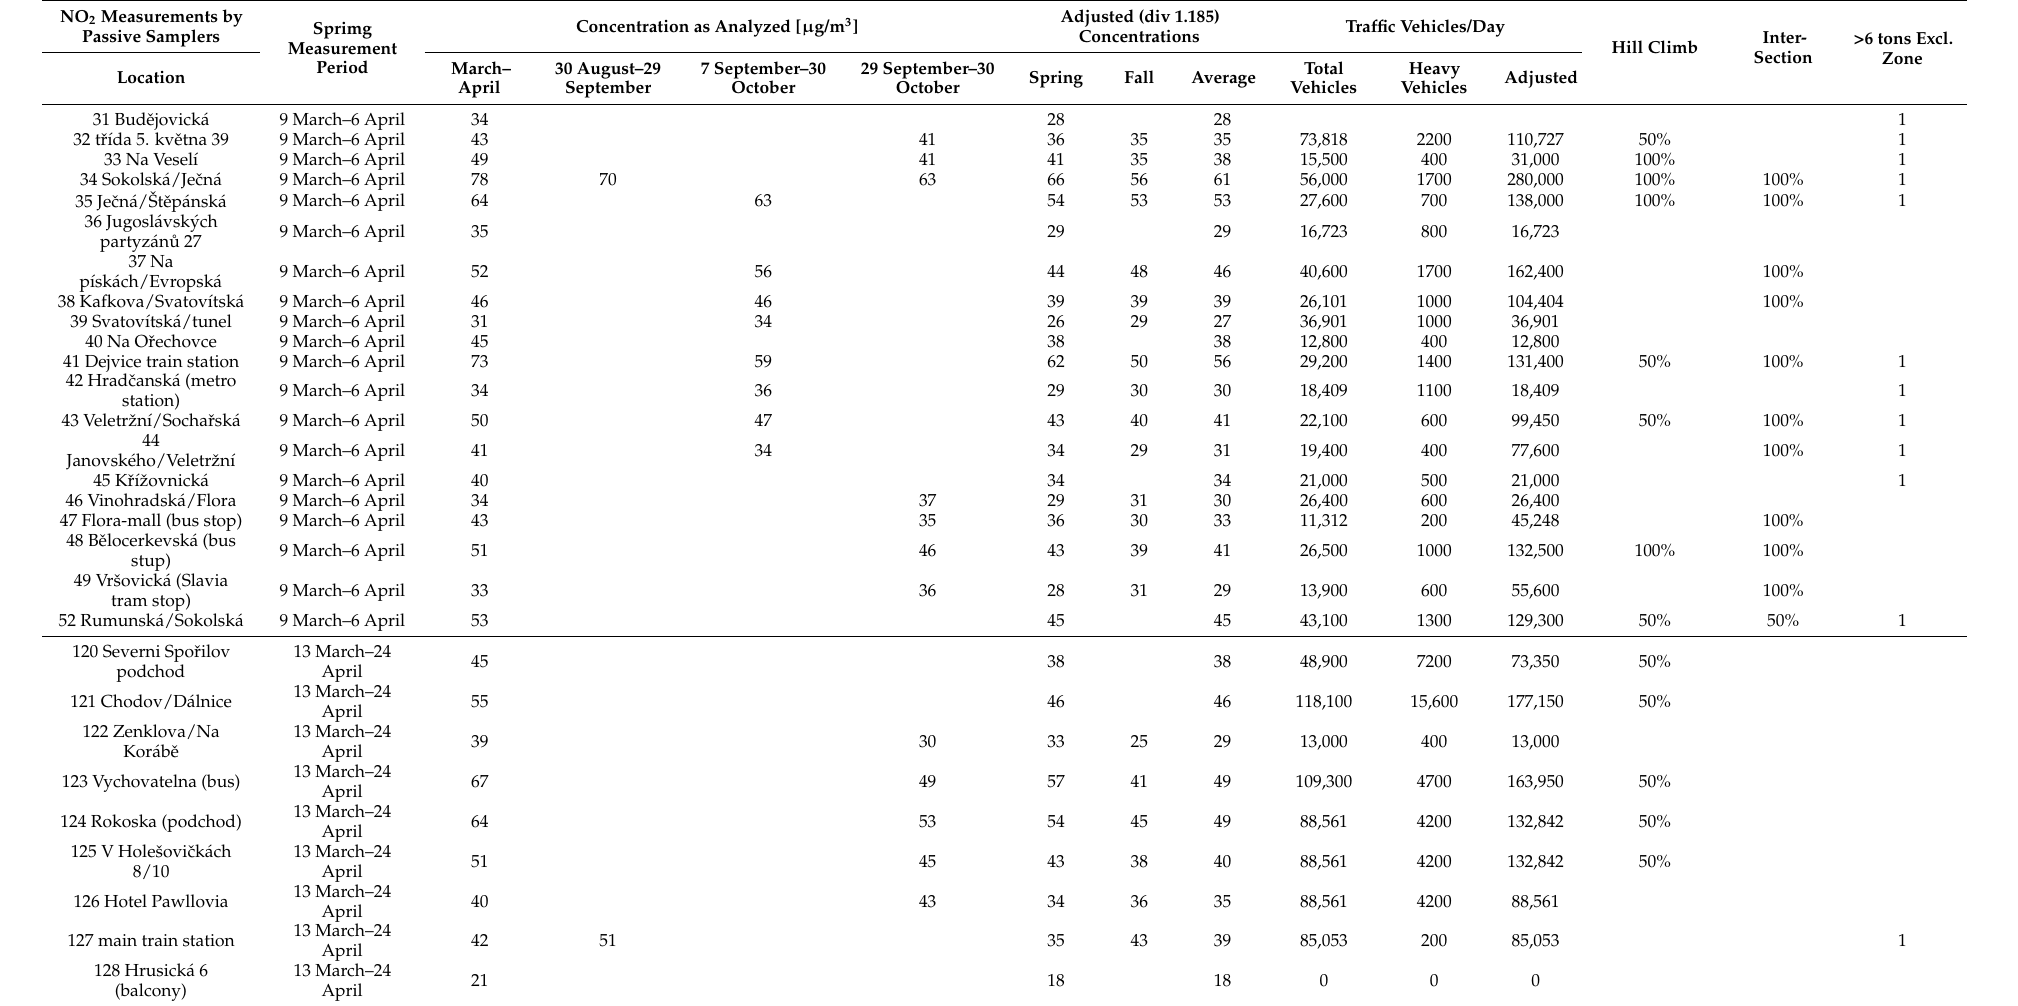
Table 1. Measured NO 2 concentrations and average daily vehicle